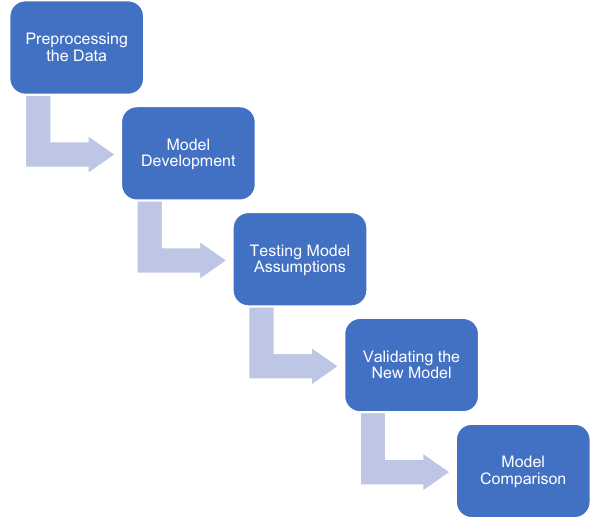
Fig. 1 Workflow of model